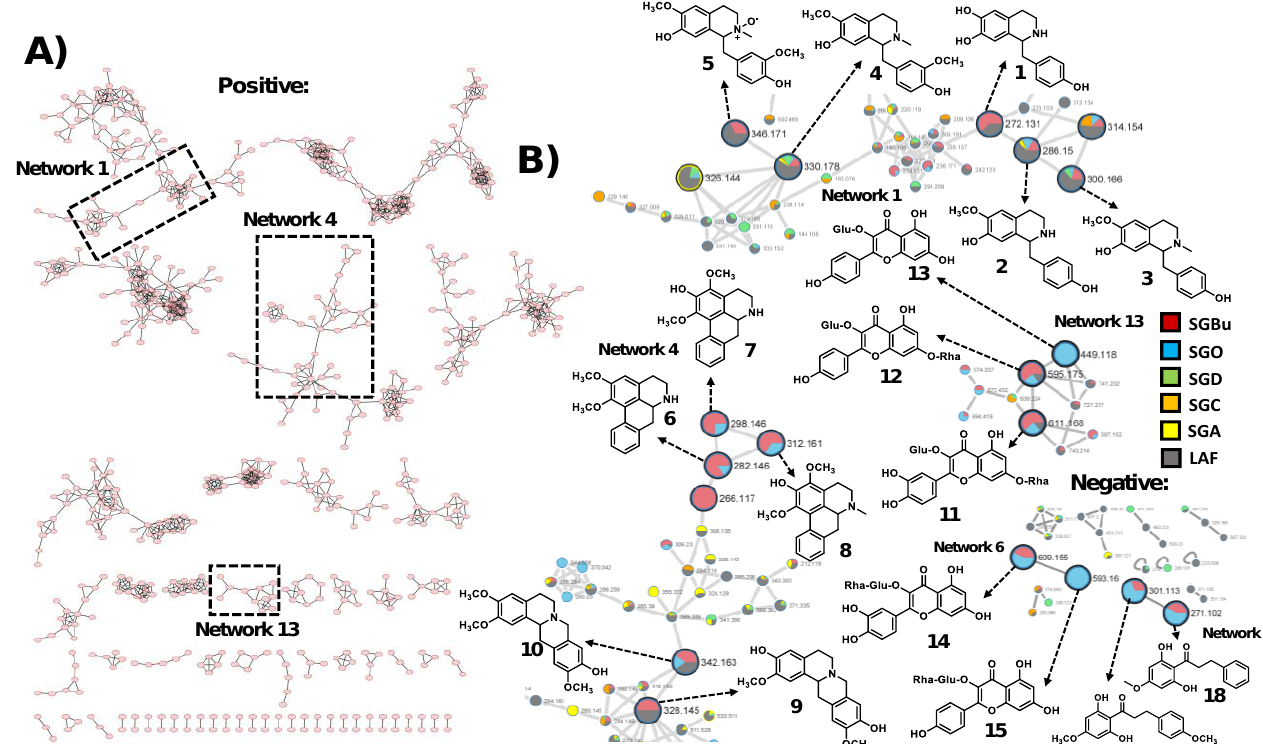
Figure 2. ( A ) Molecular networking through LC-HRMS/MS data in positive ionization mode of SGBu and bioactive CPC fractions. ( B ) Focusing on the networks with the annotated compounds in bioactive fractions through LC-HRMS/MS data in positive and negative ionization modes. Crude n -butanol extract (SGBu) SGF, SGG, SGH, SGI and SGK.